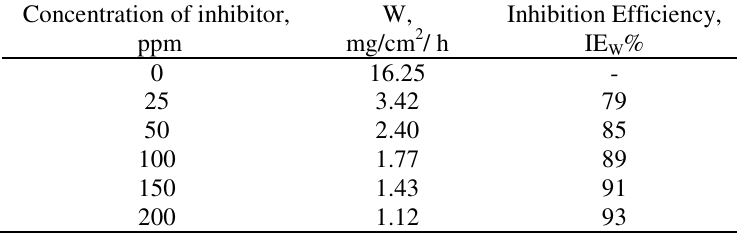
Table 1. Inhibition Efficiency of MS in 1 N H concentrations of F. exasperata extract.